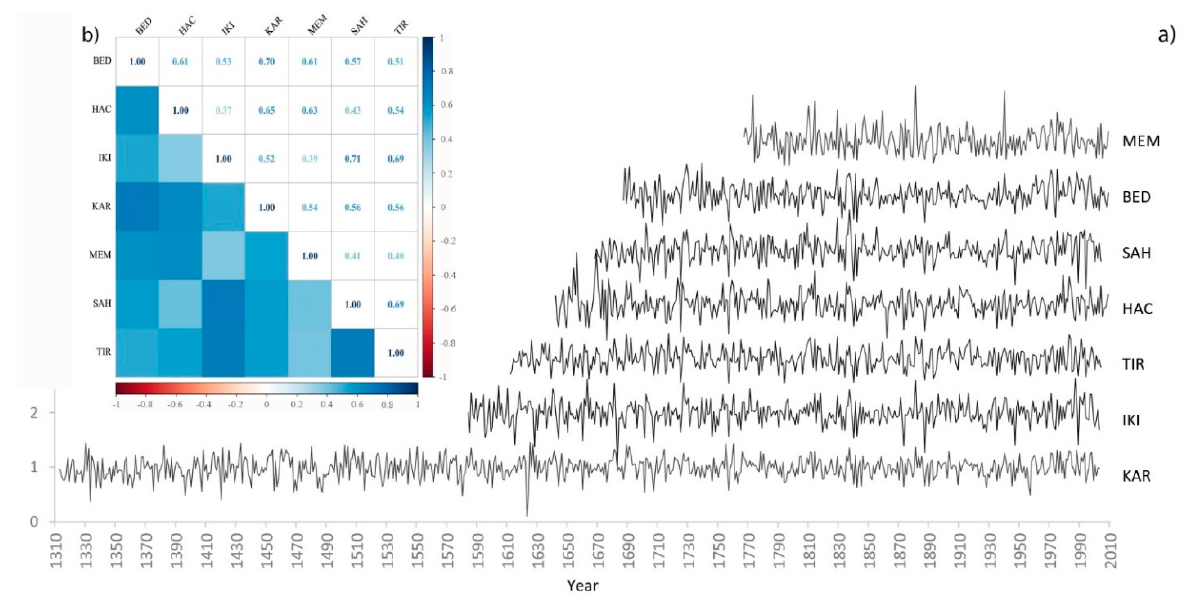
Figure 4. ( a ) The site chronologies and ( b ) correlation coefficients among each chronology for the period of 1794–2003. All correlation coefficients are significant ( p < 0.01 for MEM and IKI, p < 0.001 for the remaining ones). Table 2. Chronology statistics of the sites.